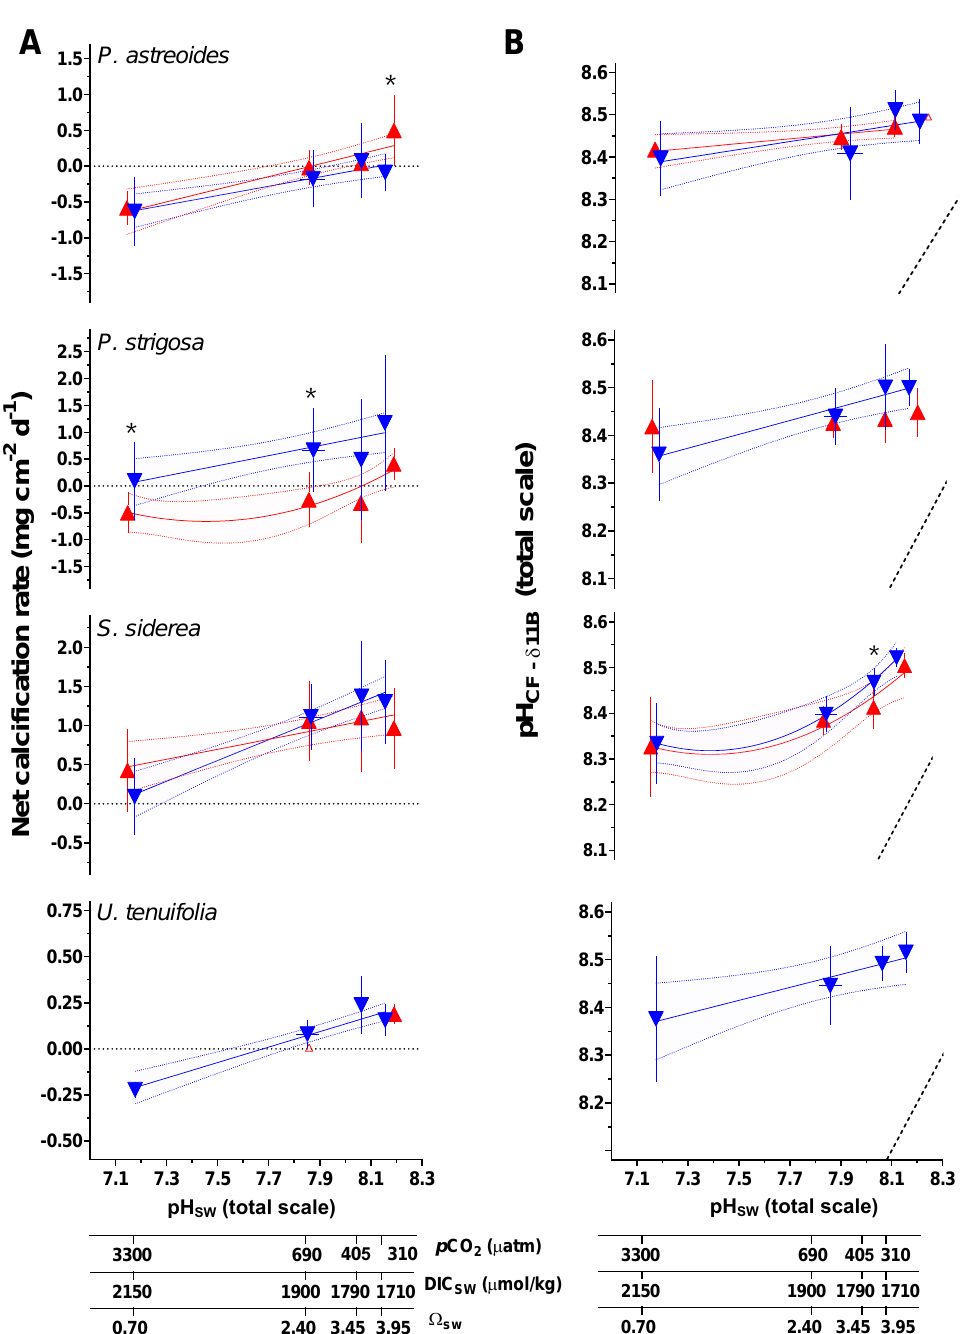
Figure 3. ( A ) Measured net calcification rate (mg cm − 2 d − 1 ), replotted from Bove et al. [38]. ( B ) δ 11 B-derived pH CF . Triangle symbols represent the mean value ( ± 1 SD) for each treatment condition, blue and red symbols represent the 28 ◦ C and 31 ◦ C treatments, respectively. Linear versus centered quadratic fit was determined using the Akaike’s Information Criteria test (Table S8), with shading representing the 95% confidence interval. * indicates a significant difference between 28 ◦ C and 31 ◦ C data for a given p CO 2 treatment, as demonstrated by a p -value < 0.05 in a Welch’s